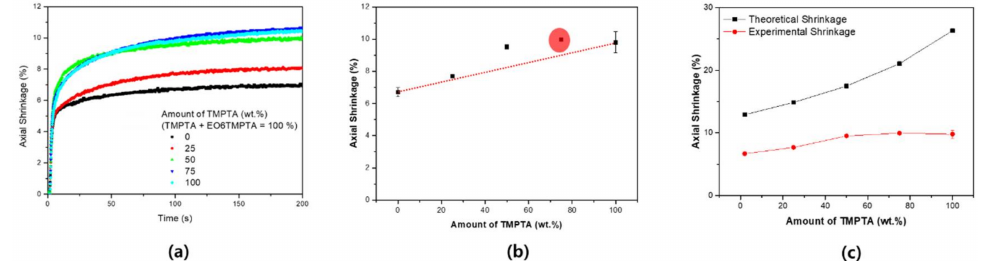
Figure 3. The shrinkage ratio of the binary system: ( a ) real-time axial shrinkage; ( b ) maximum shrinkage of the binary monomer system (red circle: highest shrinkage point); and ( c ) comparison of theoretical shrinkage and experimental